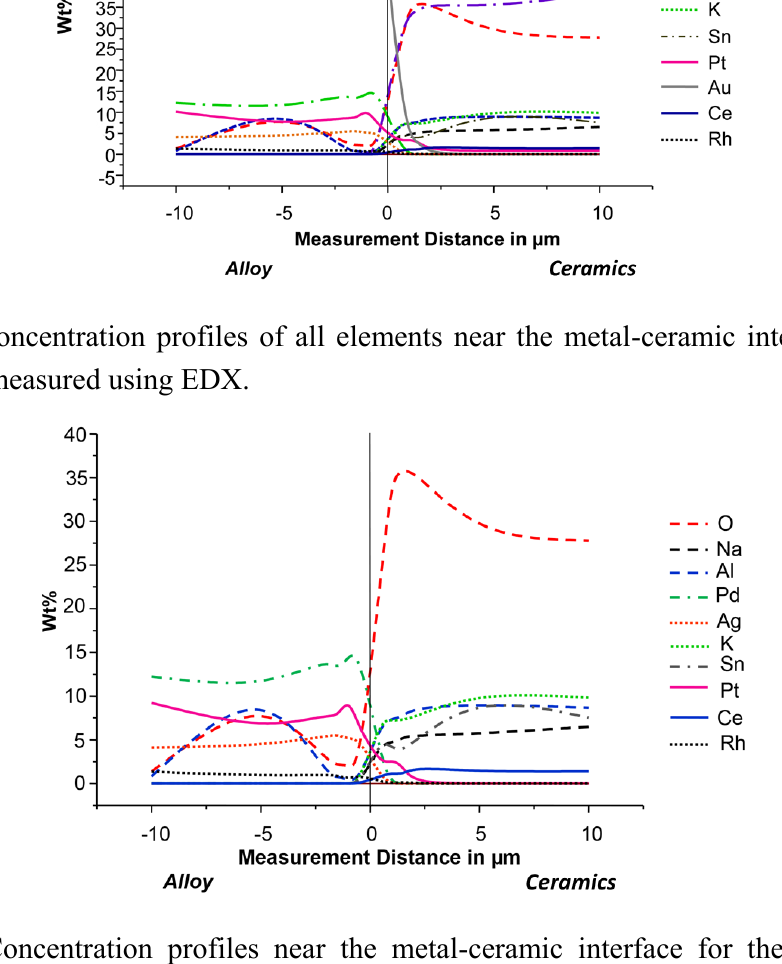
Figure 3. Concentration profiles near the metal-ceramic interface for the series P St, measured using EDX. For better representation of the chemical elements present at a lower concentration, the high concentration elements in Figure 2, Au and Si, were